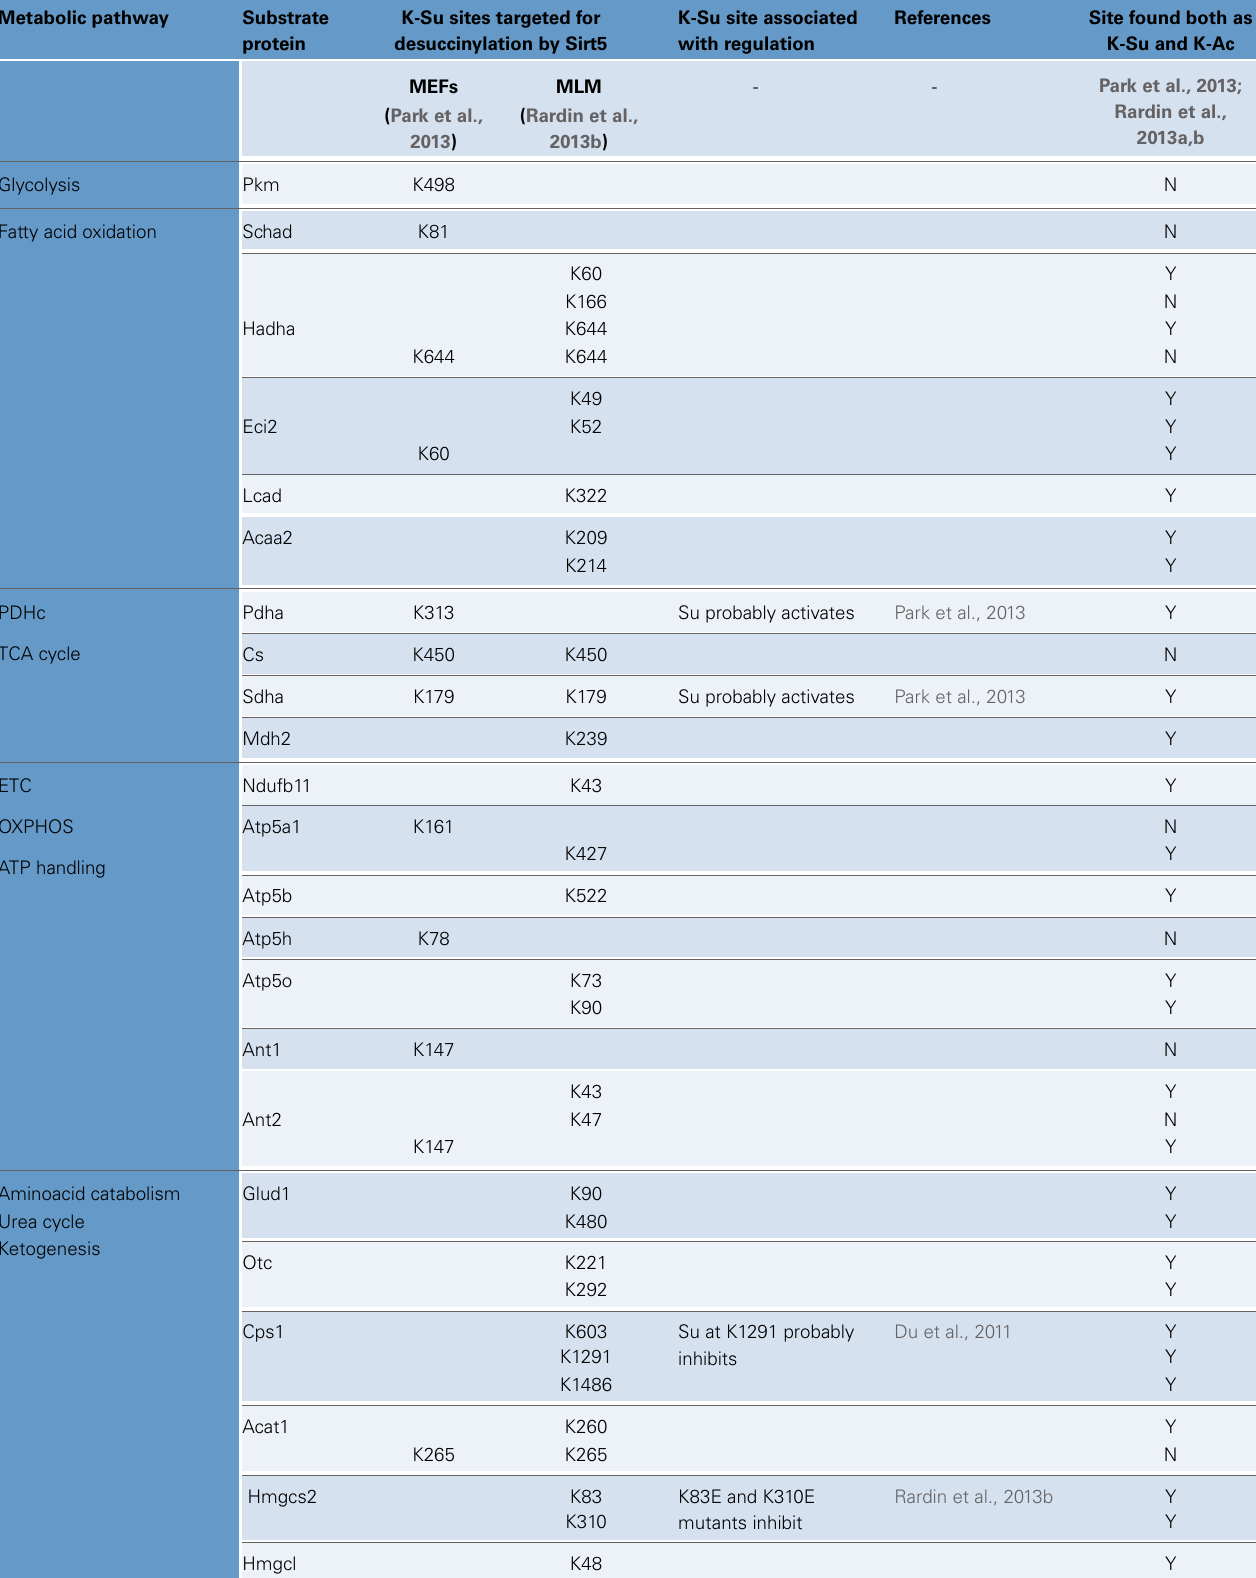
Table 3 | Protein succinylation, regulation by Sirt5 and functionally important